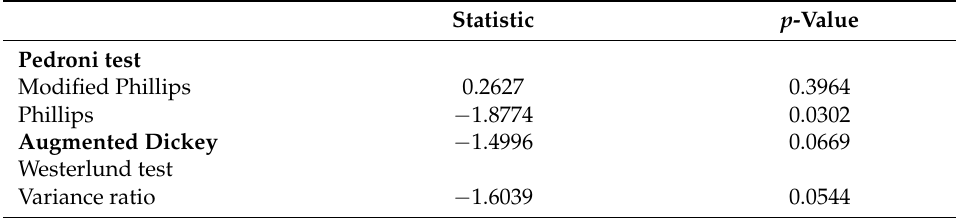
Table 4. Pedroni and Westerlund tests—results 1